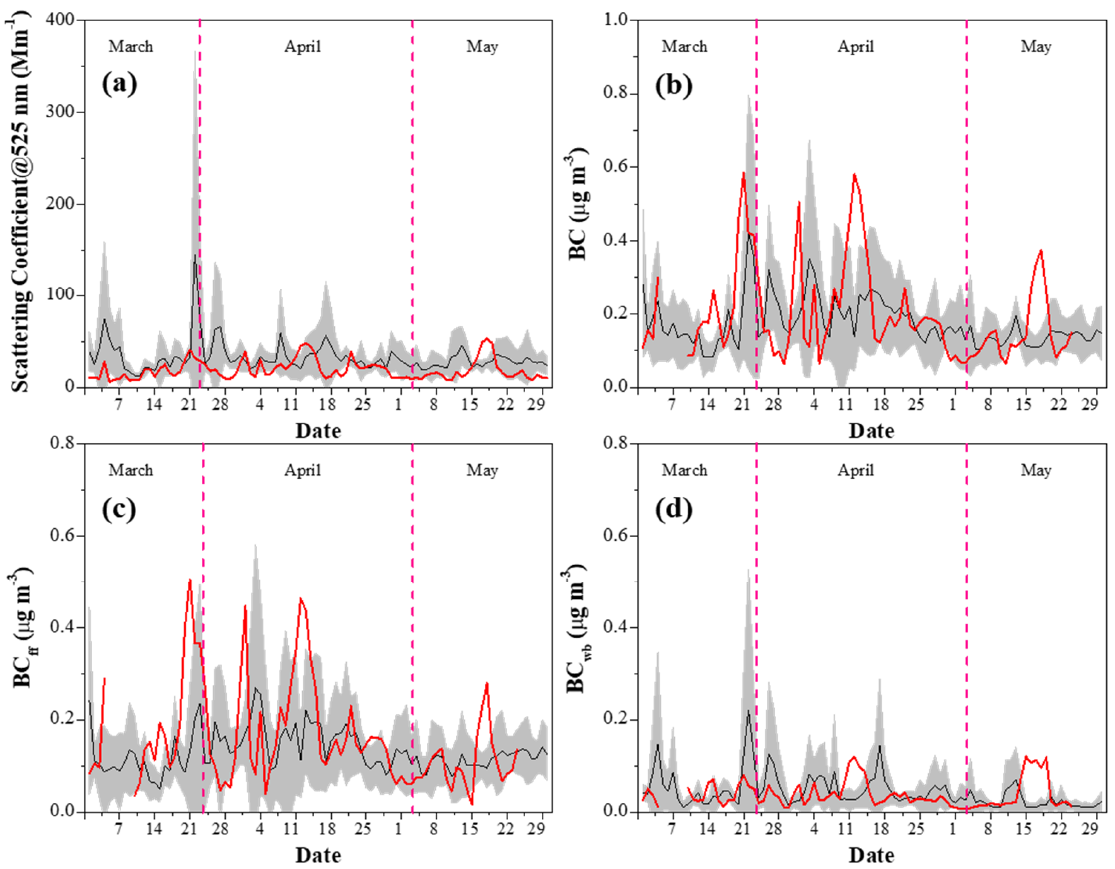
Figure 2. Daily variation of the scattering coefficient ( a ), black carbon (BC) ( b ), BC ff ( c ) and BC wb ( d ) concentrations at Finokalia, Crete during March–May of 2016–2019 (black) and in 2020 (red). The gray area corresponds to the standard deviation of each parameter during 2016–2019.